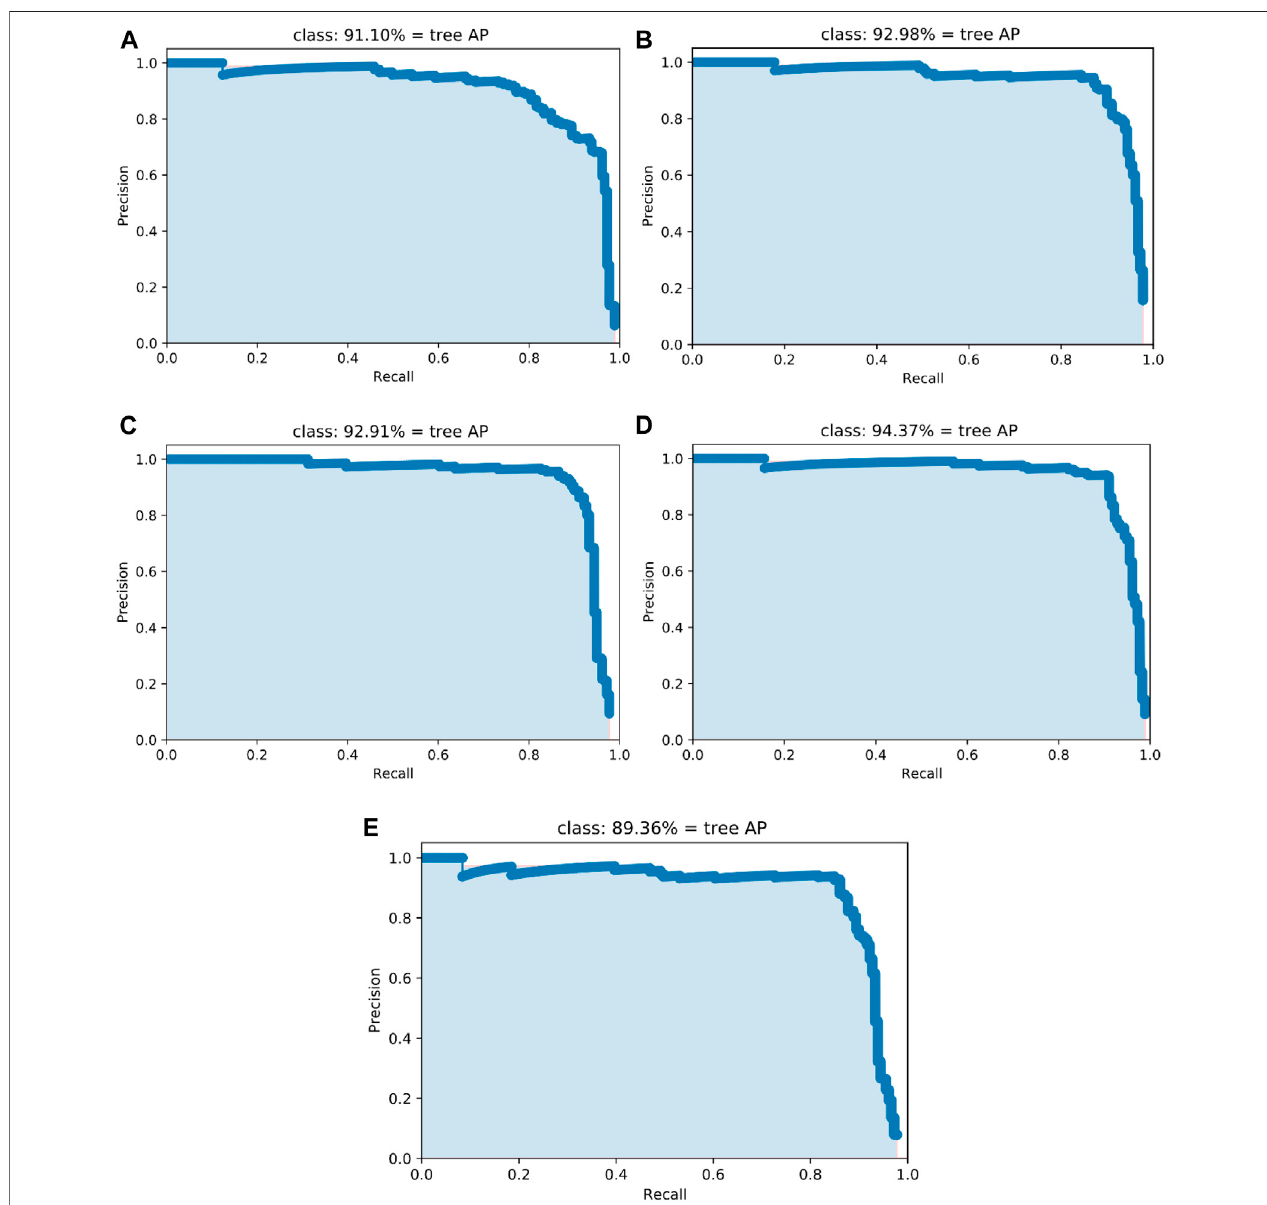
FIGURE 10 | Precision-recall curves for each method. (A) Model 1 (B) Model 2. (C) Model 3. (D) Model 4. (E) Model 5.